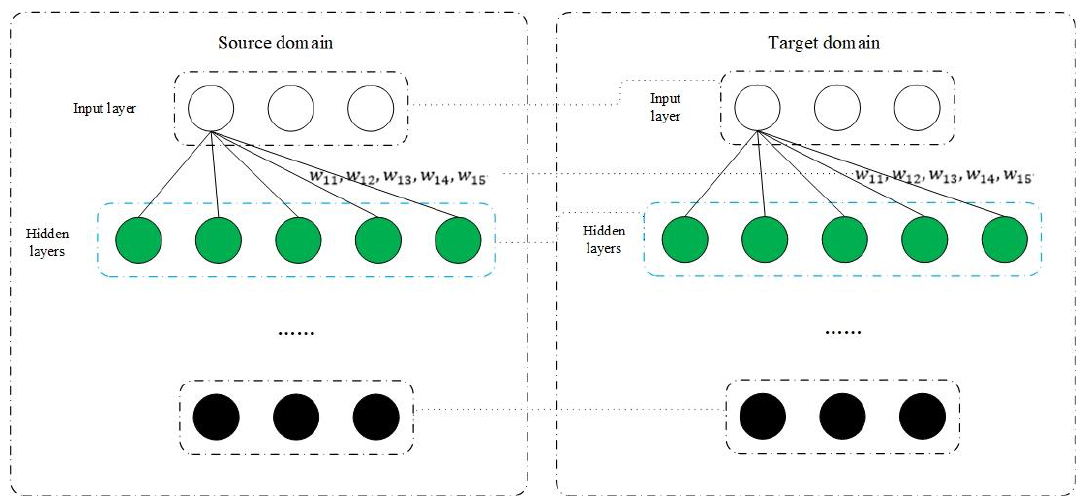
Figure 3. TS2 Transfer only the network structure, the weights of the new network is randomly initialized.